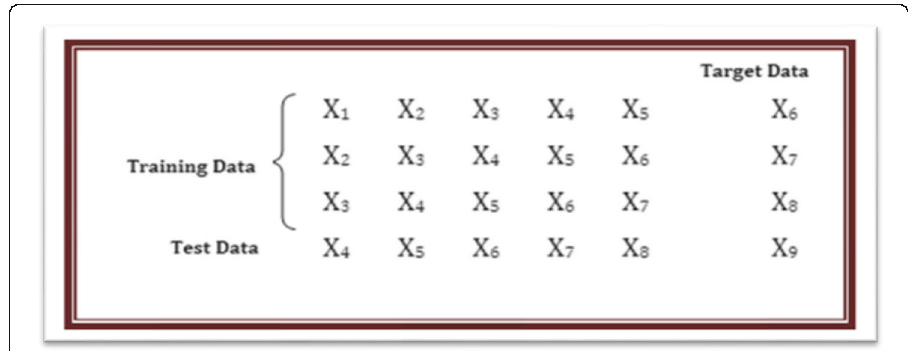
Fig. 8 Training window generation for one-day-ahead forecasting